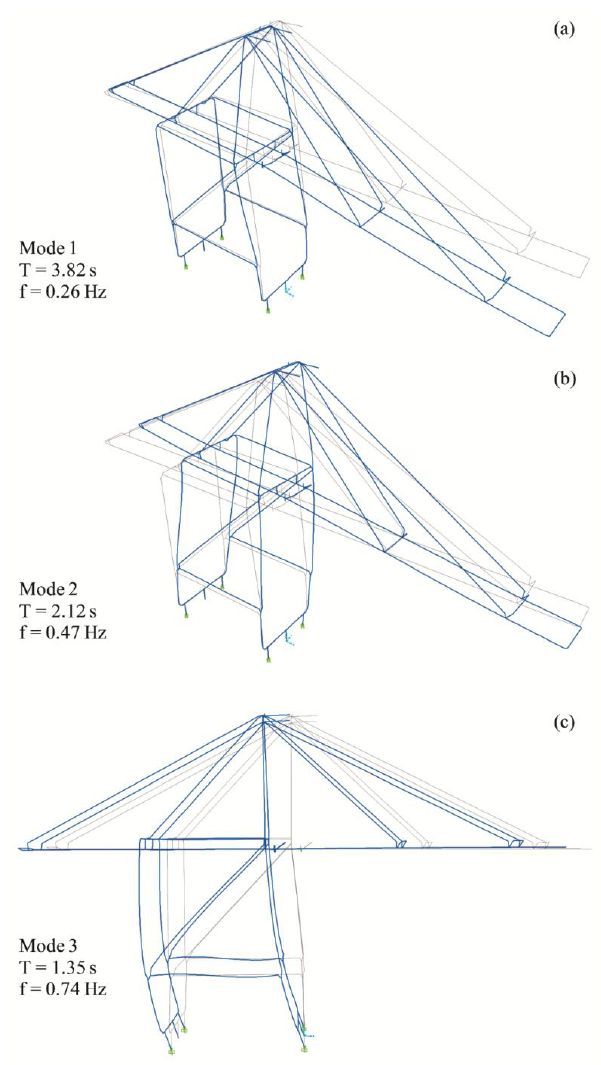
Figure 4. Mode shapes and natural periods of three first significant modes of the crane: ( a ) Torsion of boom, ( b ) Torsion of frame, and ( c ) Portal sway in trolley travel direction.